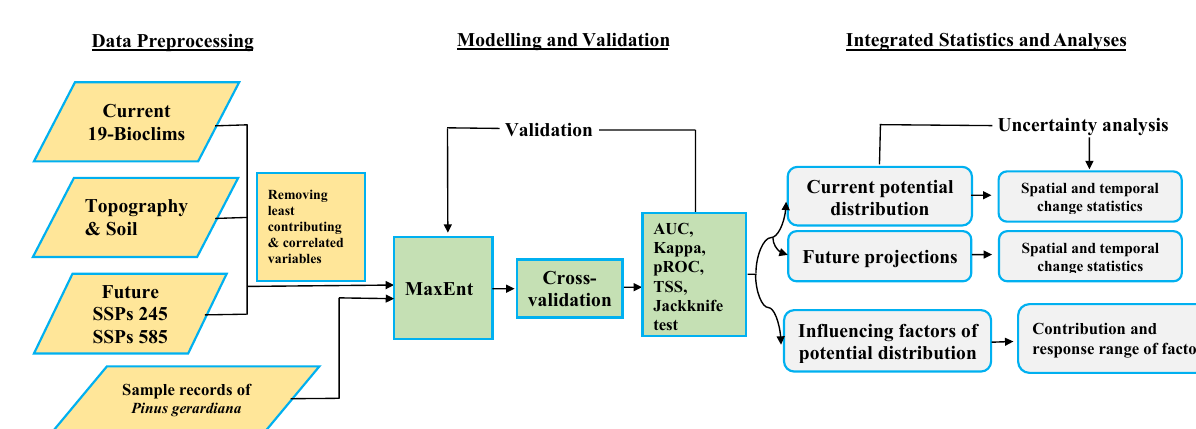
Figure 2. Flow chart of methodology used in MaxEnt entropy modelling of Chilgoza Pine.